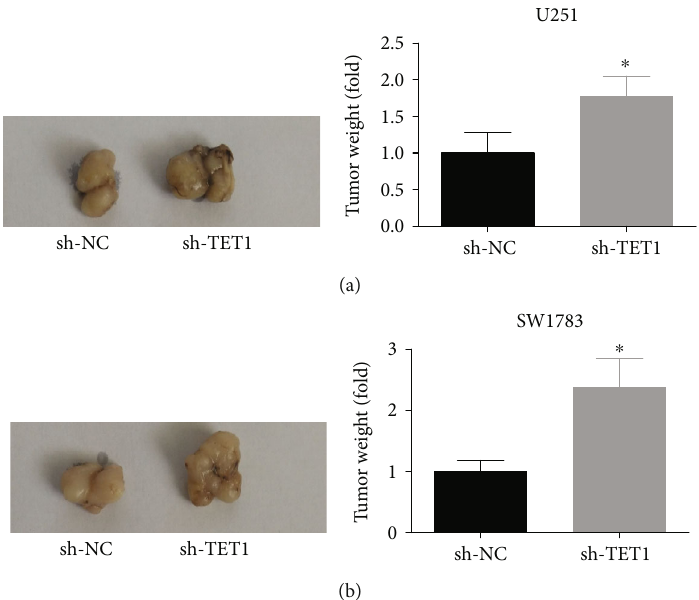
Figure 5: TET1 de fi ciency promoted proliferation of U251 and SW1783 cells in vivo. (a, b) Nude mice were injected with U251 and SW1783 cells which were transfected with negative control shRNA and TET1 shRNA. The tumors were excised after 30d, and the weights were calculated. ∗ P < 0 : 05